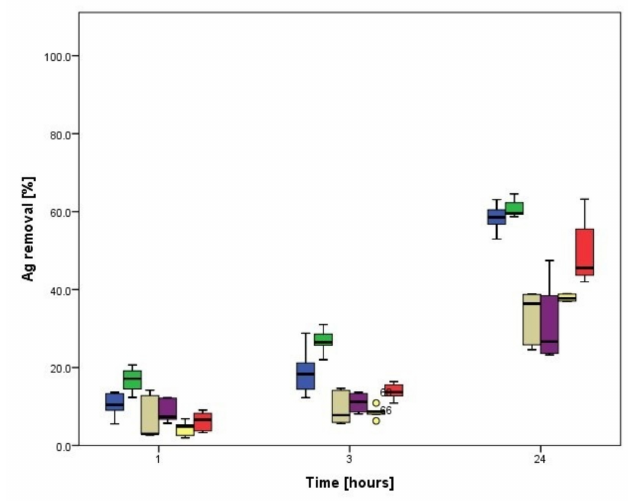
Figure 6. Ag removal by 0.050 g (wet weight) of Cladosporium cladosporioides pellets at different pH values and contact times. pH: (cid:4) : 2; (cid:4) : 3; (cid:4) : 4; (cid:4) : 5; (cid:4) : 6; (cid:4) : 7.